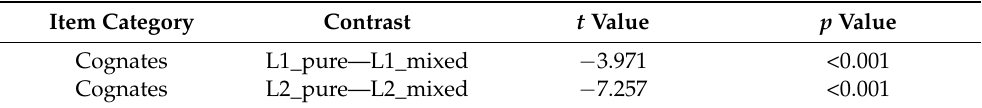
Table 5. Emmeans comparison of cognate processing between pure and mixed language